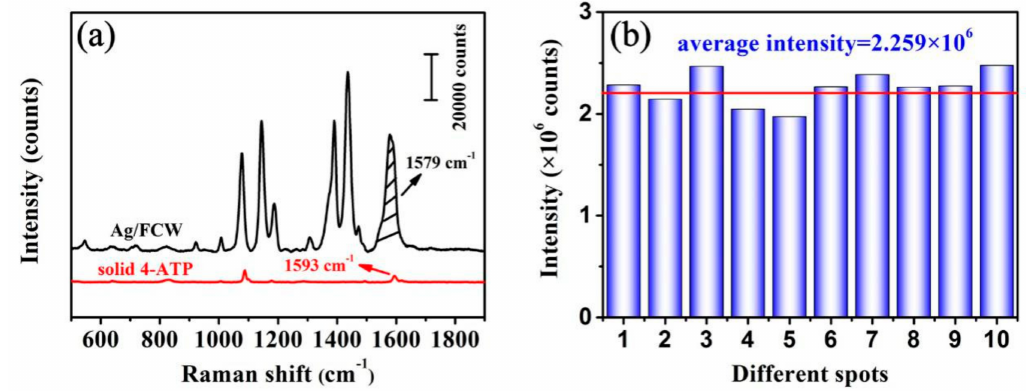
Figure 8. ( a ) SERS spectrum of 10 − 3 M 4-ATP solution absorbed onto the Ag/FCW-10 substrates and Raman spectrum of solid 4-ATP; and ( b ) the intensity distribution of 10 − 3 M 4-ATP at 1579 cm − 1 measured from 10 different pots (the average intensity is marked with red